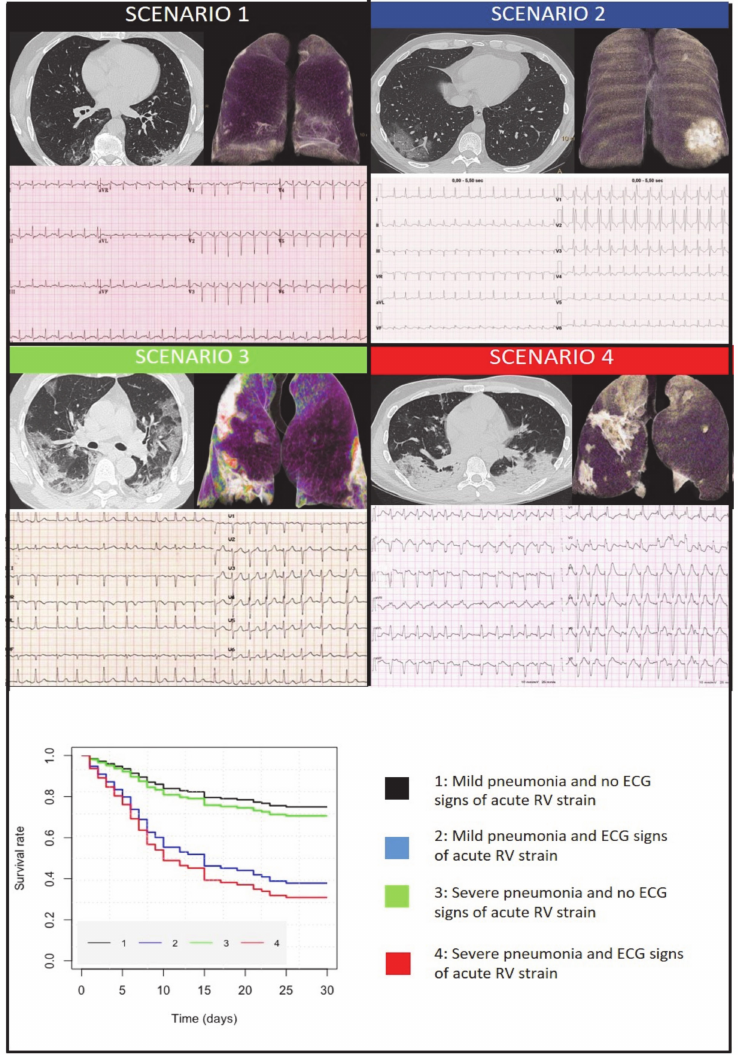
Figure 2. Four clinical scenarios of COVID-19 patients based on combined electrocardiographic (ECG) and chest computed (CT) information (axial image and 3D volumes rendering of lungs in antero-posterior view). Scenario 1 : mild pneumonia without ECG signs of acute right ventricular (RV) strain; Scenario 2 : mild pneumonia with ECG signs of acute RV strain; Scenario 3 : severe pneumonia without ECG signs of acute RV strain; Scenario 4 : severe pneumonia with ECG signs of acute RV strain. Kaplan–Meir survival curves related to the four scenarios in the lower